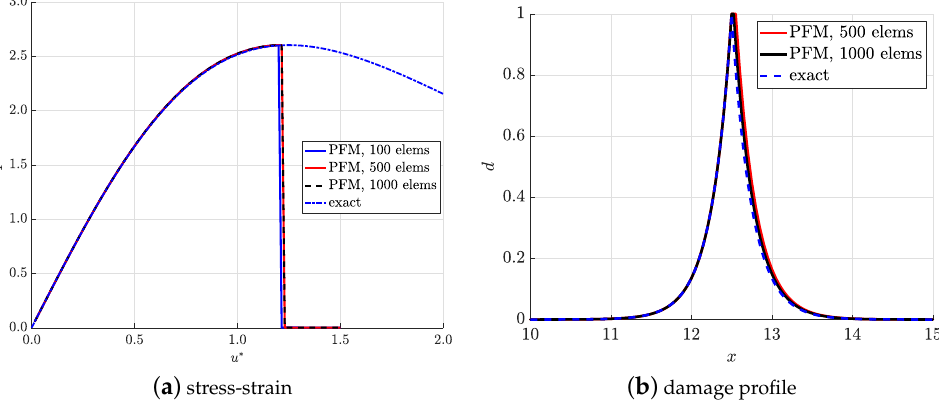
Figure A1. Mesh convergence analysis. PFM, Phase-Field